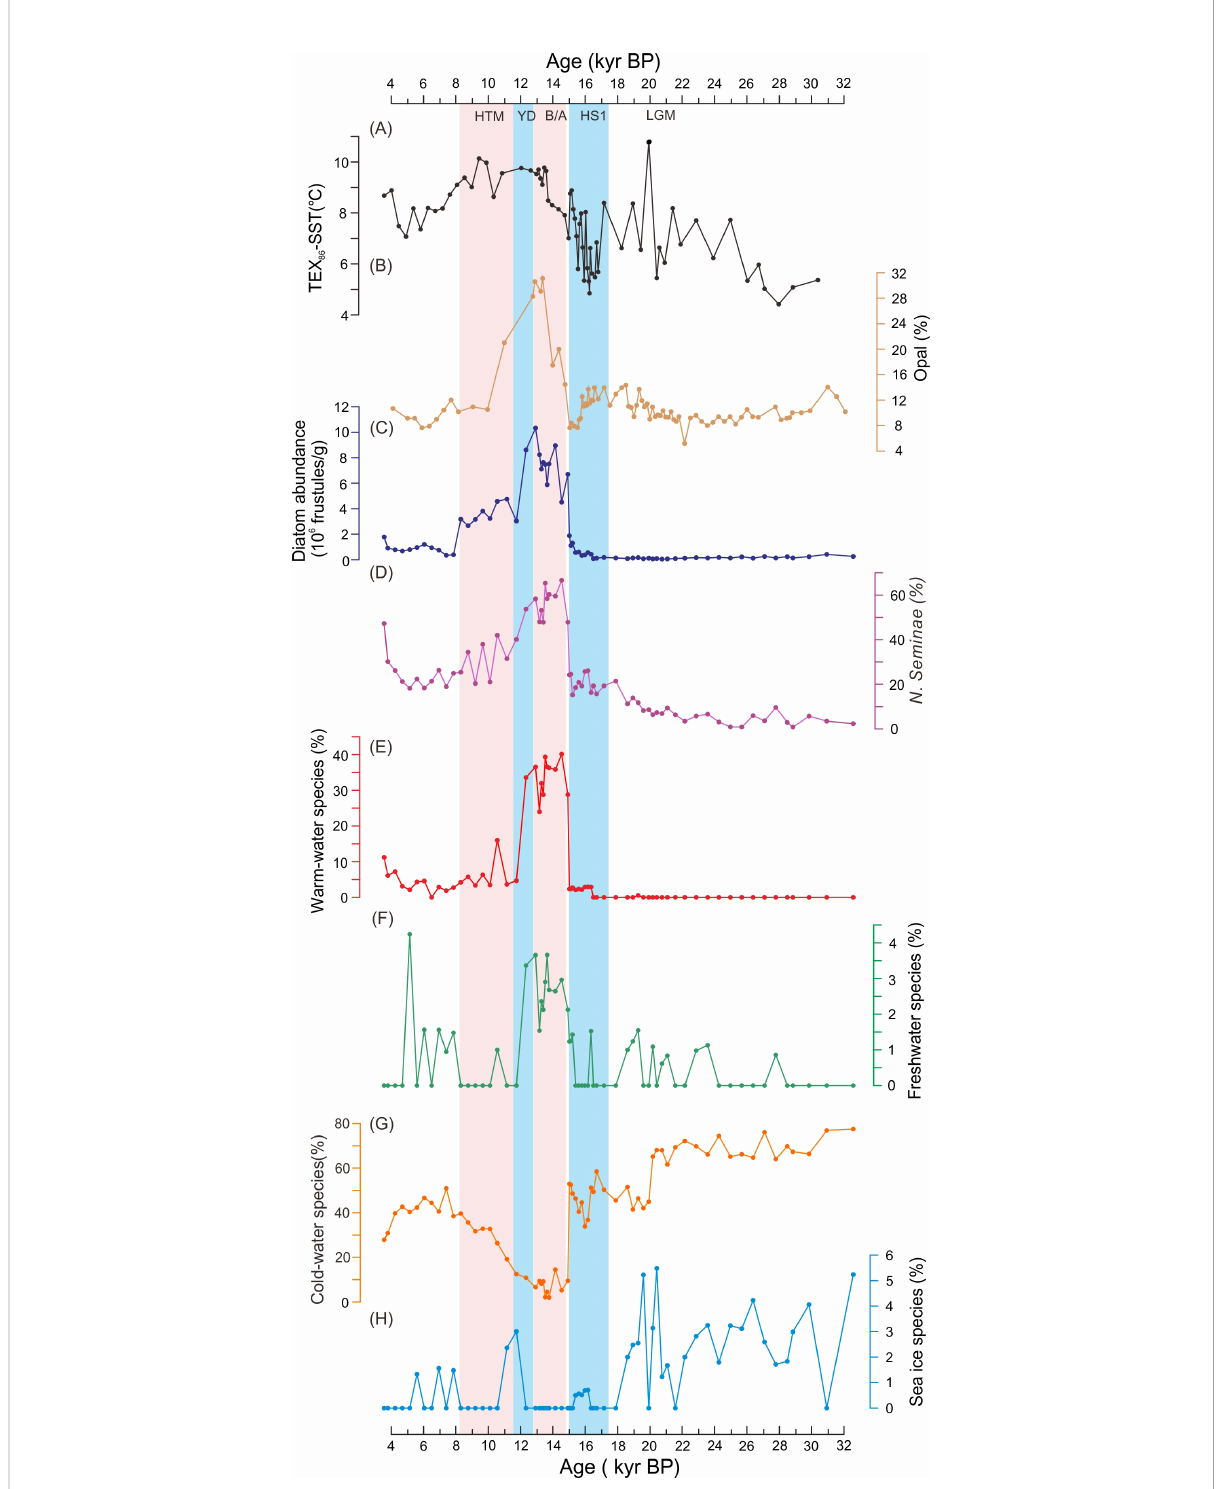
FIGURE 3 Records re fl ecting changes in sea surface temperature (SST) and biological production in core LV63-4-2 over the past 32 kyr: (A) TEX L 86 -SST, (B) opal concentration, (C) diatom abundances, (D) Neodenticula seminae , (E) warm-water species, (F) freshwater species, (G) cold-water species, and (H) sea-ice species. The pink and dark shading denote the warm intervals of the Bølling-Allerød [B/A] and the Holocene Thermal Maximum [HTM], respectively, and the blue shading denotes the cold intervals of Heinrich Stadial 1 [HS1] and the Younger Dryas stadial